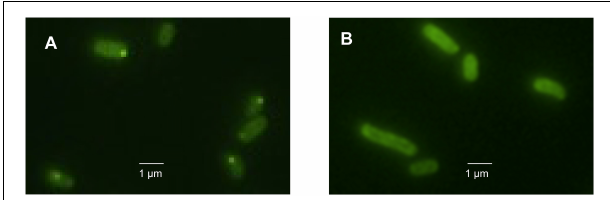
FIGURE 5 | Images of E. coli MG1655 ibpA-yfp cells harboring pRK767 (A) or pLHR (B) after treatment of 70 ◦ C for 5 min.